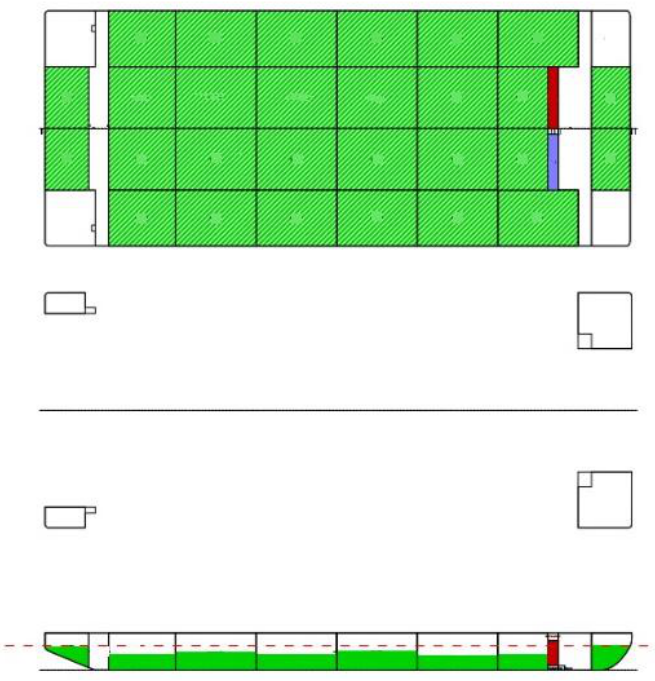
Figure 16. Schematic diagram of LCS1 ballast water distribution.